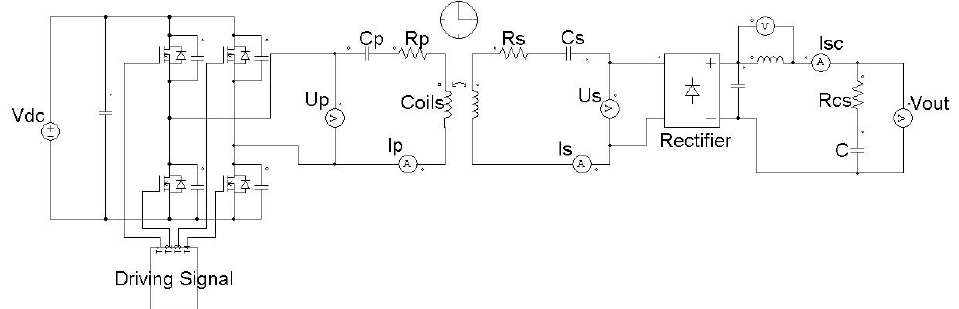
Figure 13. PSIM simulation model.